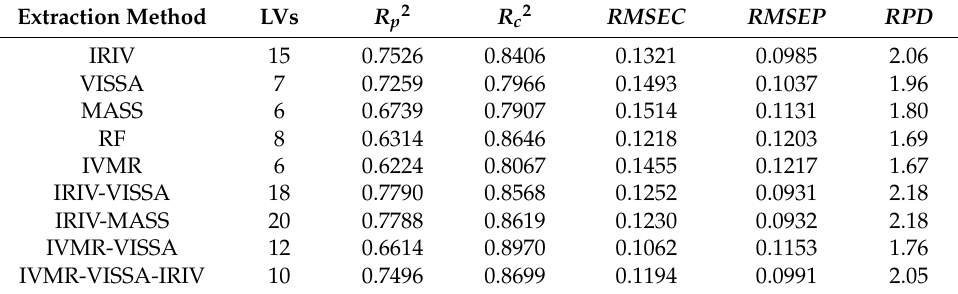
Table 6. The prediction results of